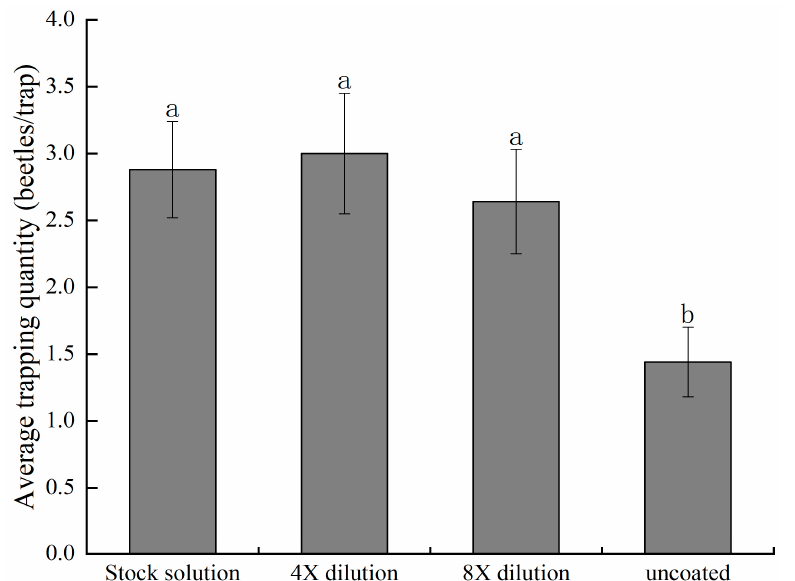
Figure 2. Effect of Teflon concentration on trapping of Monochamus alternatus in Jiaxing. Different letters on bar top indicate significant differences between treatments. ( α = 0.05).